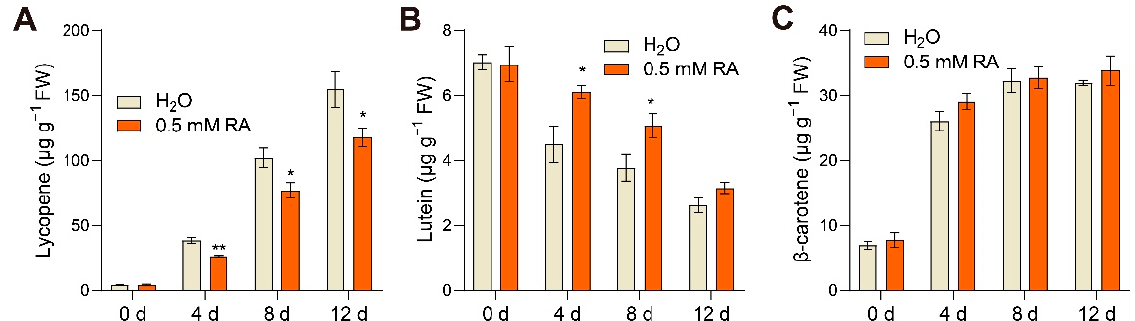
Figure 3. RA affected carotenoid biosynthesis during fruit ripening. Effects of RA treatment on ( A ) lycopene content, ( B ) lutein content, and ( C ) β -carotene content during fruit ripening. Tomato fruits at the mature green stage were treated with 0.5 mM RA, or H 2 O control. The fruit samples were collected at the indicated time points for carotenoid content quantification. The data are presented as mean values ± SD; n = 3. Asterisks indicate statistically significant differences (* p ≤ 0.05, ** p ≤ 0.01) compared with control under the same time point, as determined by Student’s t -test.